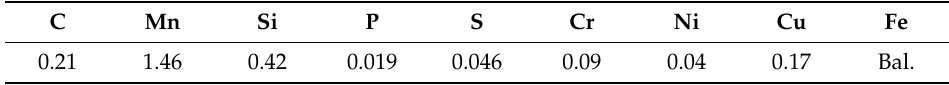
Figure 2. Shape and dimensions of specimens, dimensions in mm. Table 1. Chemical composition of experimental material (%).